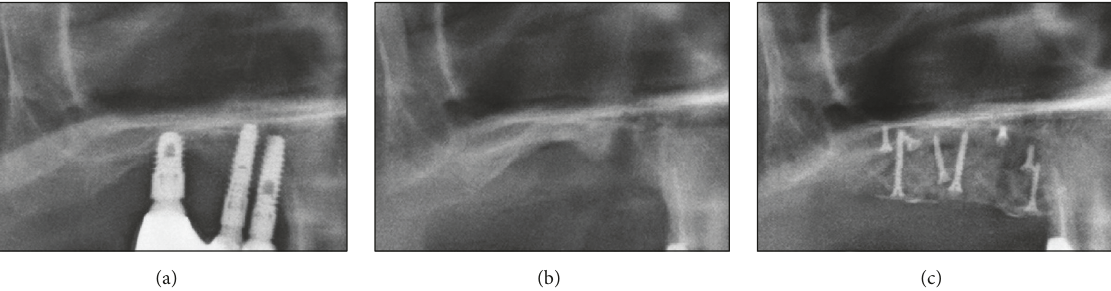
Figure 8: Postoperative radiographic view (periapical X-ray image). (a) Implant fixture with severe surrounding alveolar bone loss. (b) Implant removal site. (c) Vertical augmentation of an alveolar ridge.